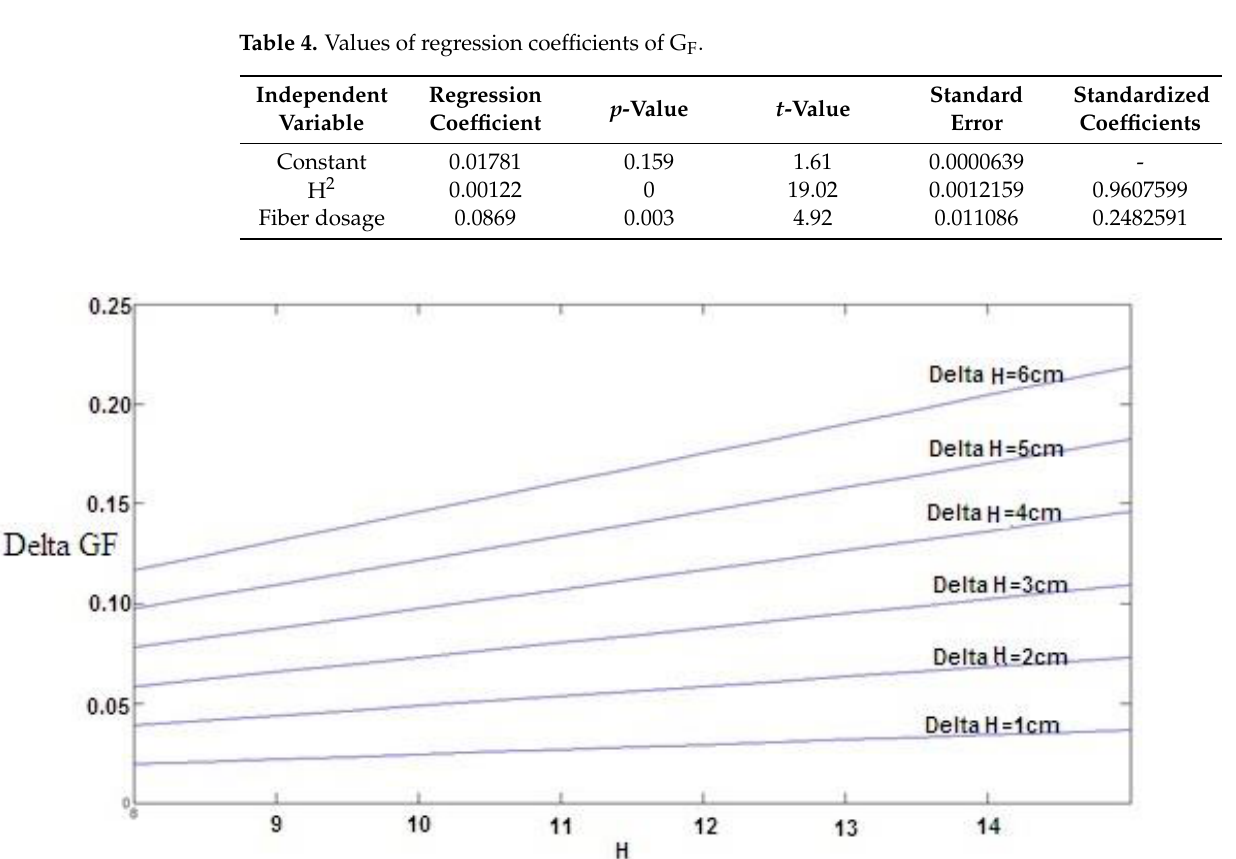
Figure 5. The effect of thickness H change on fracture energy G F.